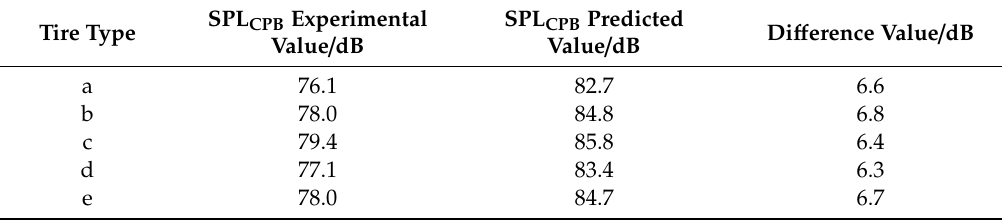
Table 4. Prediction value and di ff erence value between predicted value and experimental value at far field measurement